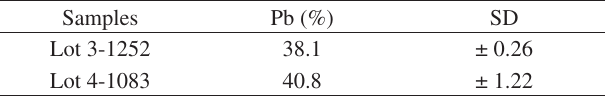
Table 1. Lead concentration of the material Permlastic ® in weight percentage and standard deviation.